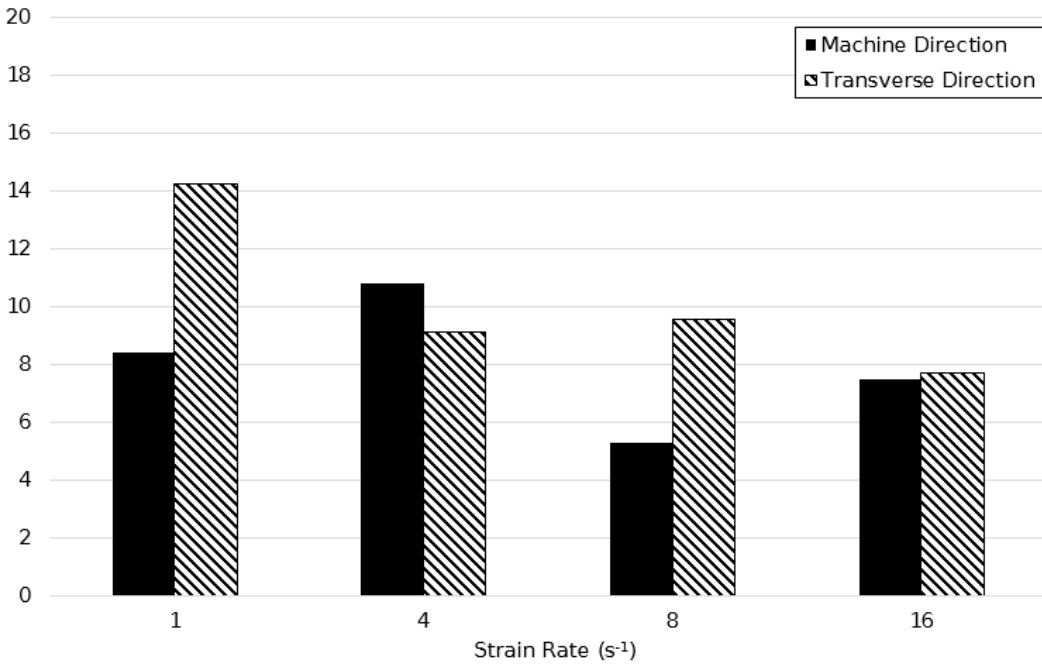
Figure 25. Normalised root mean squared error between simulated and experimentally observed stress–strain behaviour between strain rates of 1–16 s − 1 at a temperature of 140 °C.